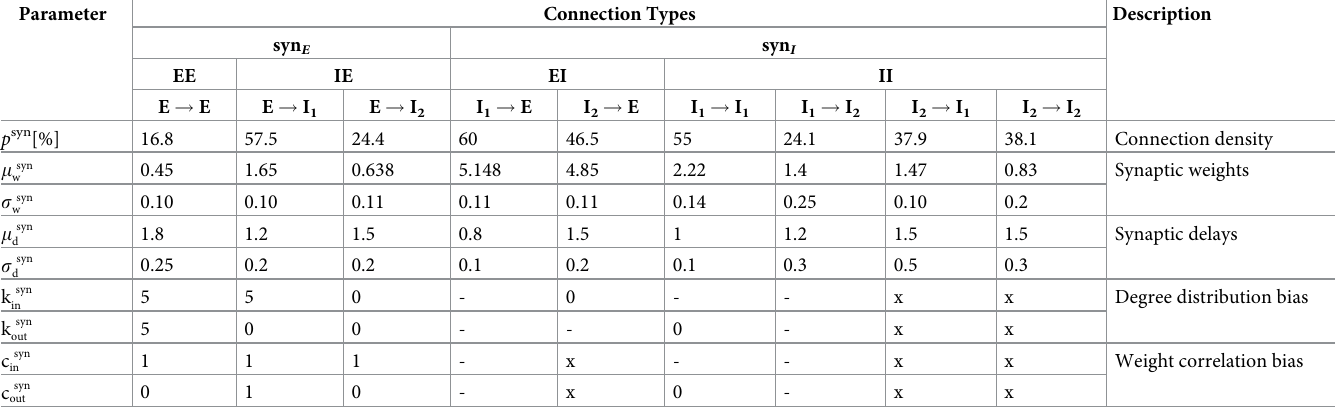
Table 3. Synaptic and structural parameters in the microcircuit. Each of the nine connection types (which can be grouped as indicated) is characterized by a specific connection density, weight and delay. In the homogeneous condition, weights and delays are fixed and equal to the mean values ( m syn whereas in the heterogeneous condition they are independently drawn from lognormal distributions with the corresponding mean and standard deviation. The last two rows in the table are the connection-specific structural bias parameters, used to skew the network’s degree and weight distributions. The indicated values were taken directly from [110] and [71]. The cases marked with—or x, correspond to connections that were either tested, revealing no significant effect (-) or untested due to missing data (x). In both cases, we set the corresponding values to